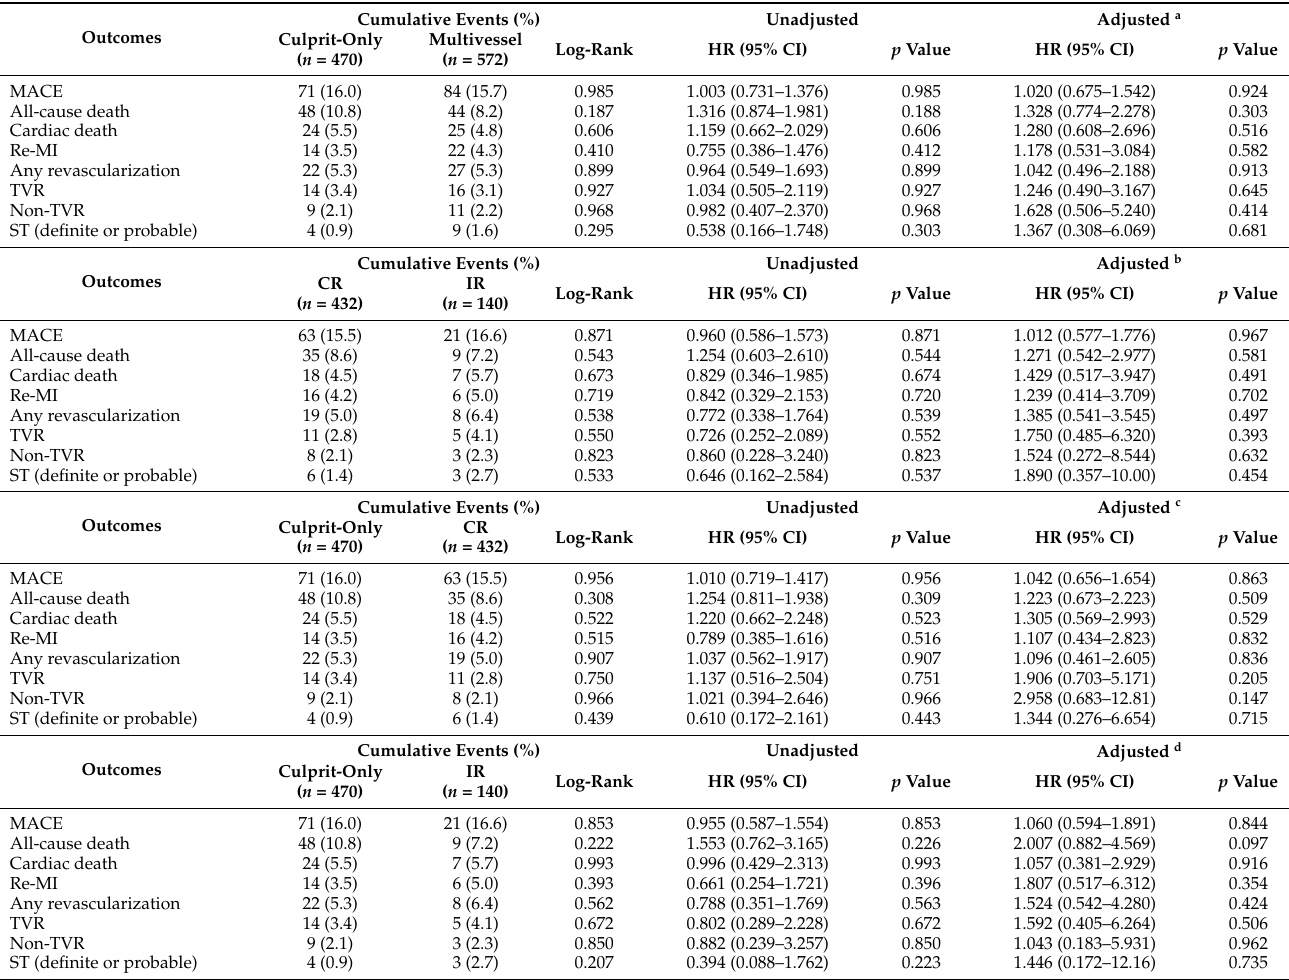
Table 2. Clinical